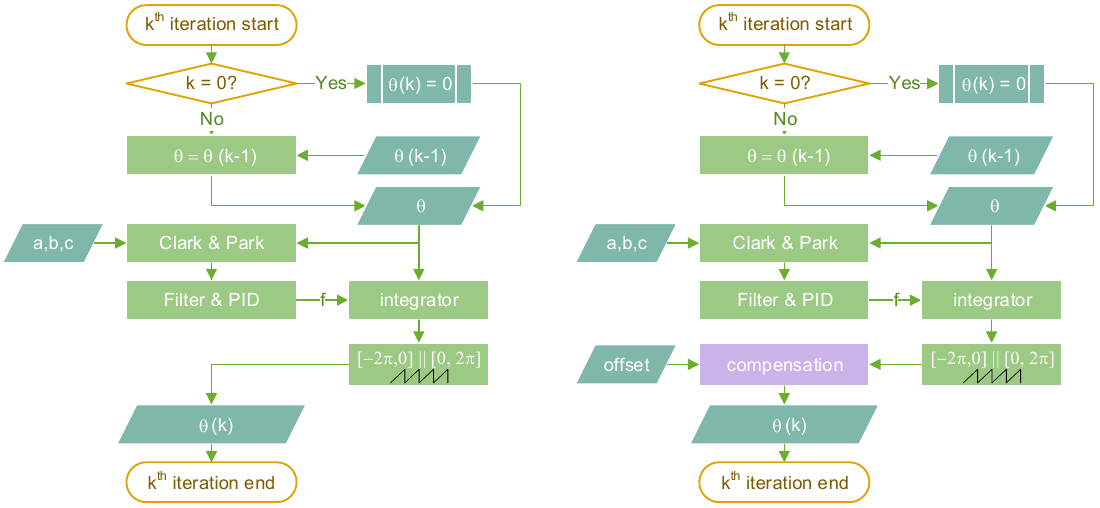
Figure 5. Digital PLL preliminary ( Left ) and improved ( Right )